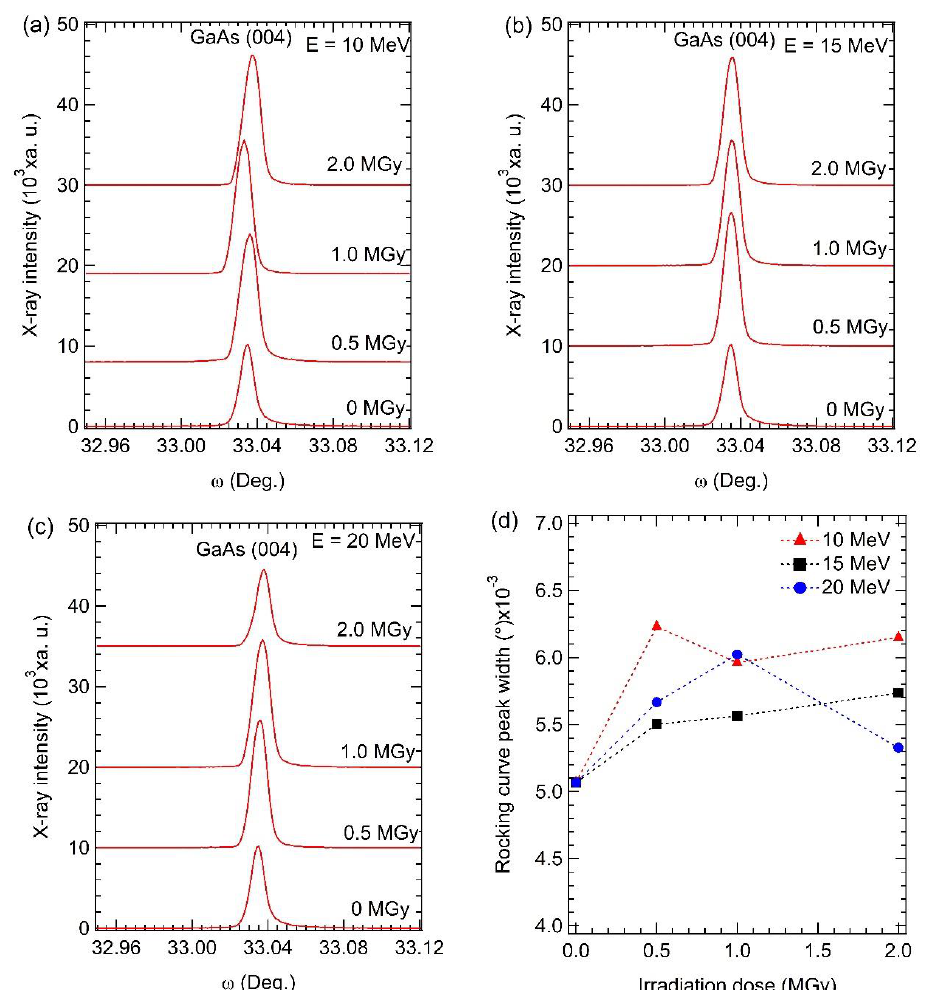
Figure 6. (004) HRXRD rocking curves of the non-irradiated and irradiated GaAs with different irradiation strengths at an electron energy of ( a ) 10; ( b ) 15; and ( c ) 20 MeV; ( d ) FWHM of (004) rocking curves.